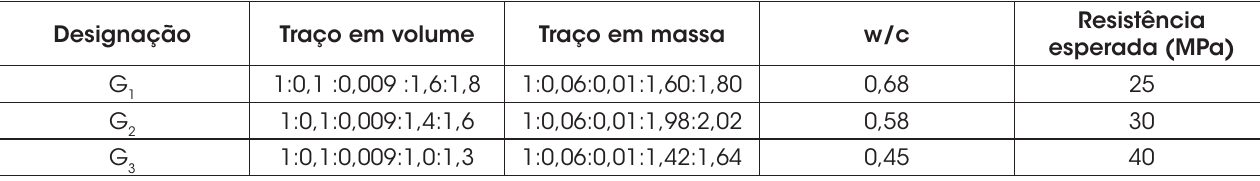
Figura 3 mostra a moldagem e os corpos-de-prova da argamassa. Utilizou-se o cimento Portland CP II-Z-32, cal hidratada e areia média, cujas massas unitárias foram determinadas durante o es- tudo. Para cada traço de argamassa foram retirados seis corpos- -de-prova para controle de resistência e do processo de produção.